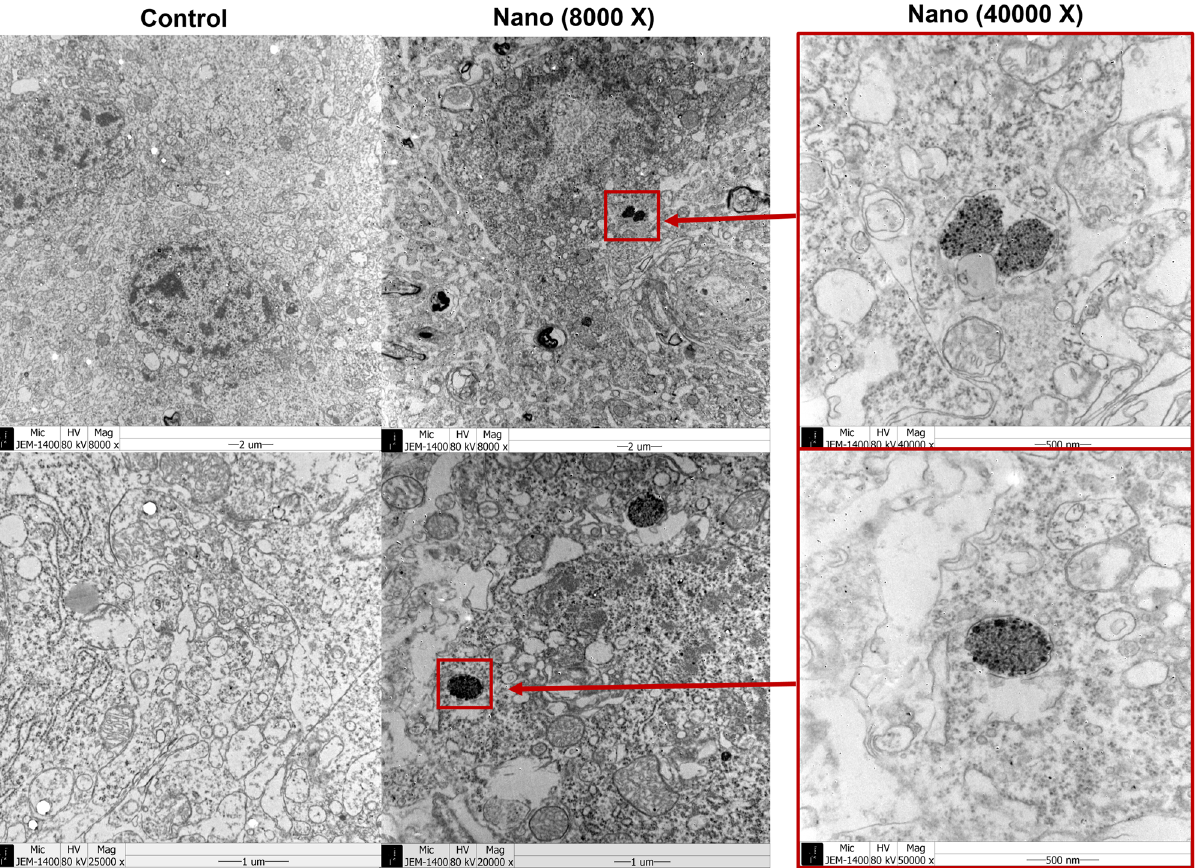
Figure 3. Transmission electron microscopic findings of olfactory bulbs of control and nano groups. The aggregates of electron-dense particles (red arrows) were identified in the olfactory bulb of nano group, which was not detected in that of control